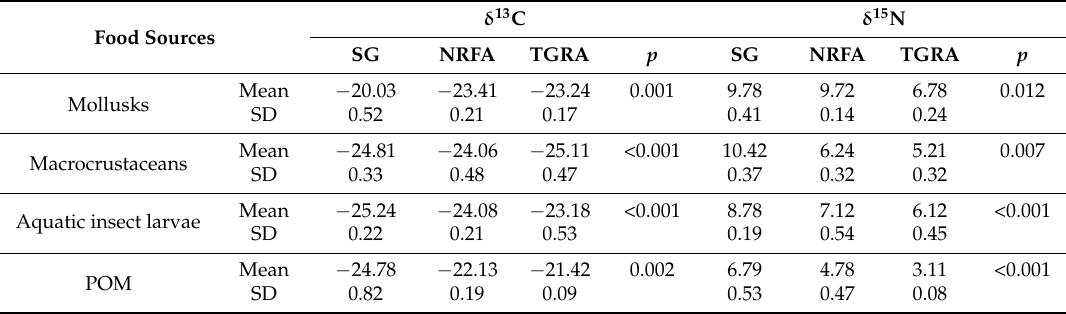
Table 3. Mean δ 13 C and δ 15 N values ( ± SD) of four food sources from three habitat types in the upper Yangtze River.